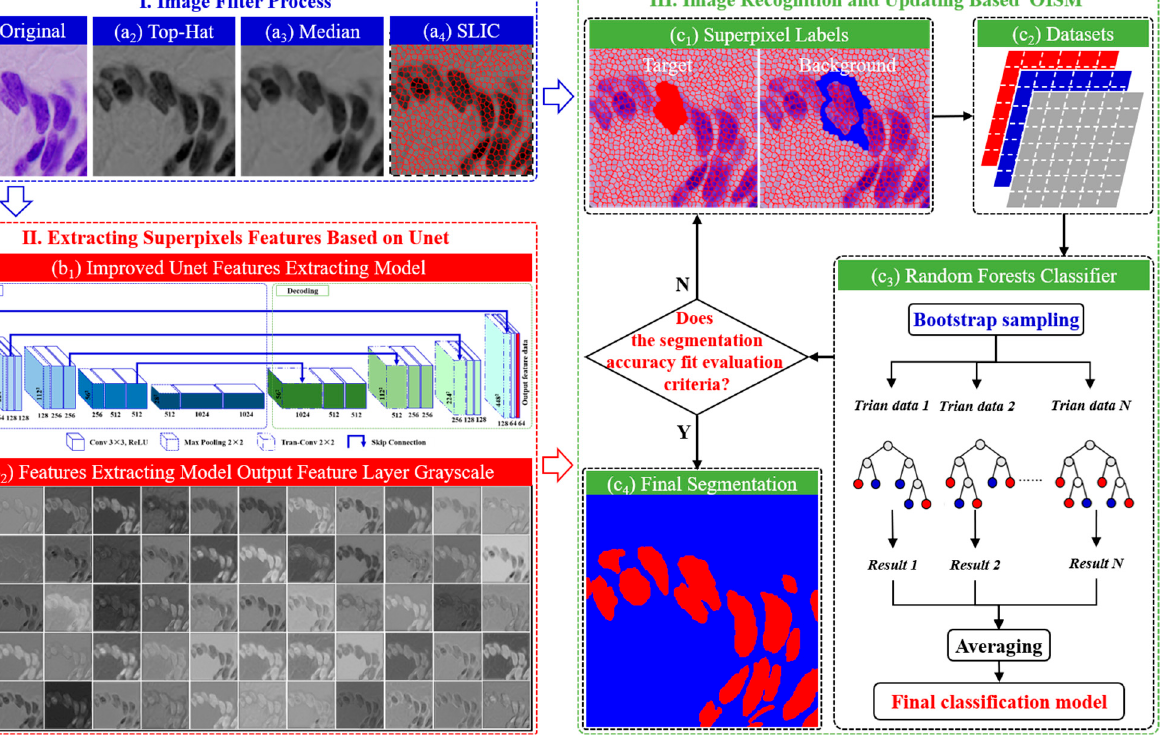
Figure 1. Framework of the proposed OISM with Unet feature migration model and SLIC superpixels. ( I ) the filter processes and SLIC superpixels results of the original image; ( II ) the improved Unet migration model and the multidimensional feature layers of input image; ( III ) the image segmentation and iteration process of the OISM based on RF.